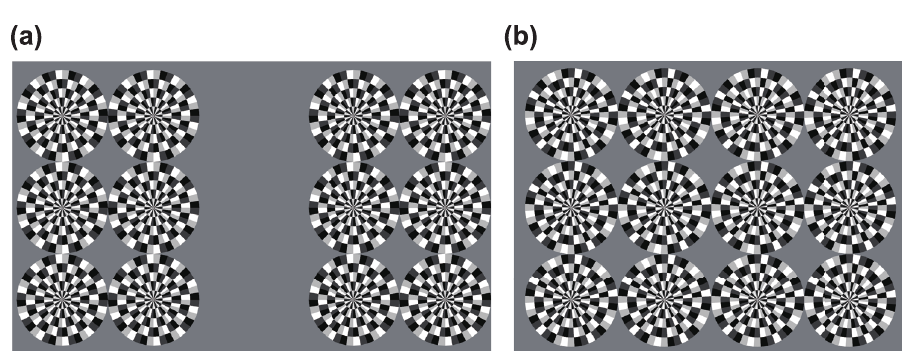
Fig 3. Experimental stimuli. (a) Images used in Experiments 1 and 3 (Clockwise image). (b) Images used in Experiment 2 (Control condition). All stimulus images consist of RSI disks with four 8-bit grayscale colors: black, dark gray, white, and light gray. The arc of each disk is 9.0 deg., and its diameter is 150 px. Two sets of six disks (Experiments 1 and 3) and one set of 12 disks (Experiment 2) are used as experimental